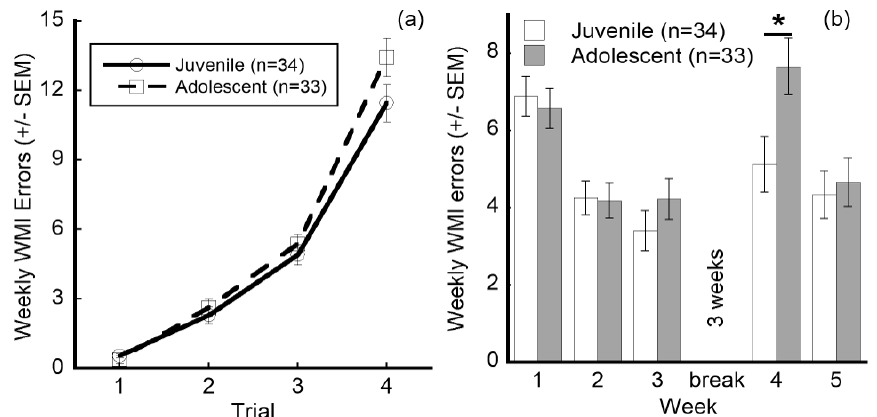
Figure 4. Effects of juvenile versus adolescent experience on performance. ( a ) Interaction of experience group and trial WMI error performance (±SEM). ANOVA indicates a significant difference between experience groups at specific trials. ( b ) Interaction of experience group and week WMI performance (±SEM). * Indicates a significant paired comparison in performance overall between the experience groups at this week, with Sidak correction for multiple comparisons.